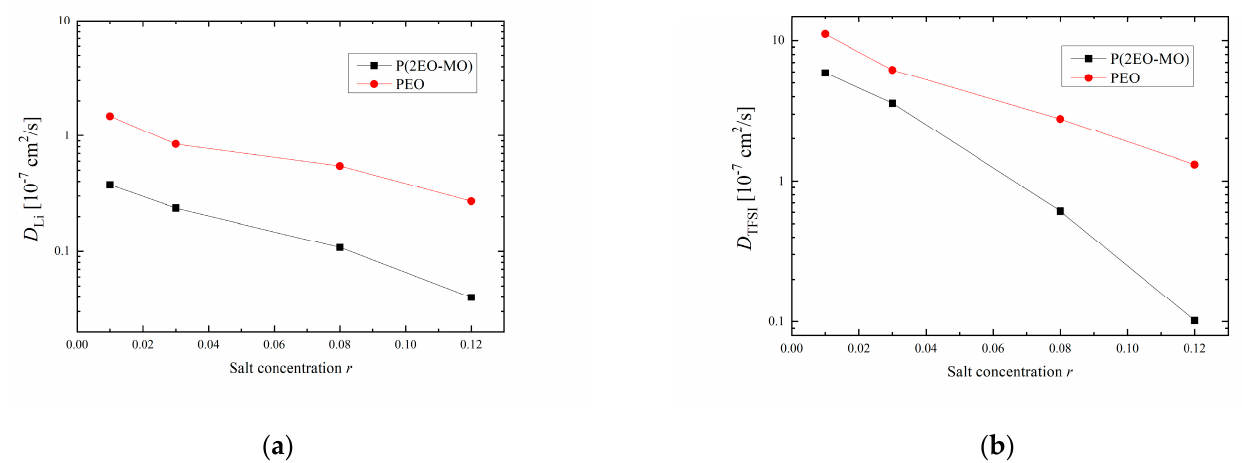
Figure 7. Salt concentration dependence of ( a ) Li ion and ( b ) TFSI ion diffusion coefficient.